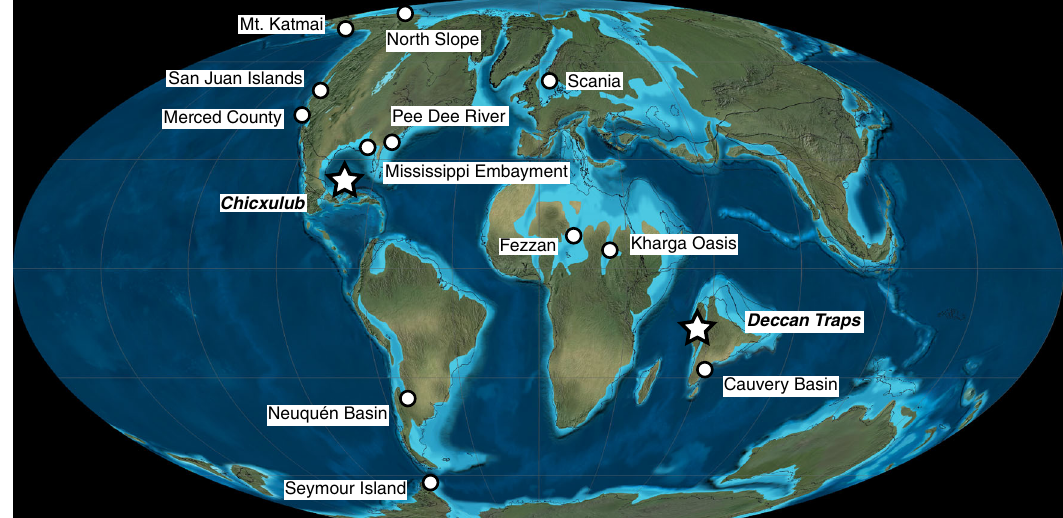
Fig. 3 Late Cretaceous paleogeography and relevant sample regions of the study. Depicted is a paleogeographic reconstruction at the time of the K – Pg Boundary, labeled with specimen sample regions. Individual regions often constitute several localities where sampling occurred either historically or by the authors. Additional specimen details can be found in Supplementary Note 1. Locations of the Deccan Traps large igneous province and the Chicxulub impact event are demarcated with star-shaped symbols. The global paleogeography Mollweide projection base map of the K – Pg Boundary is used with permission from the license holder © 2016 Colorado Plateau Geosystems, Inc 61 .